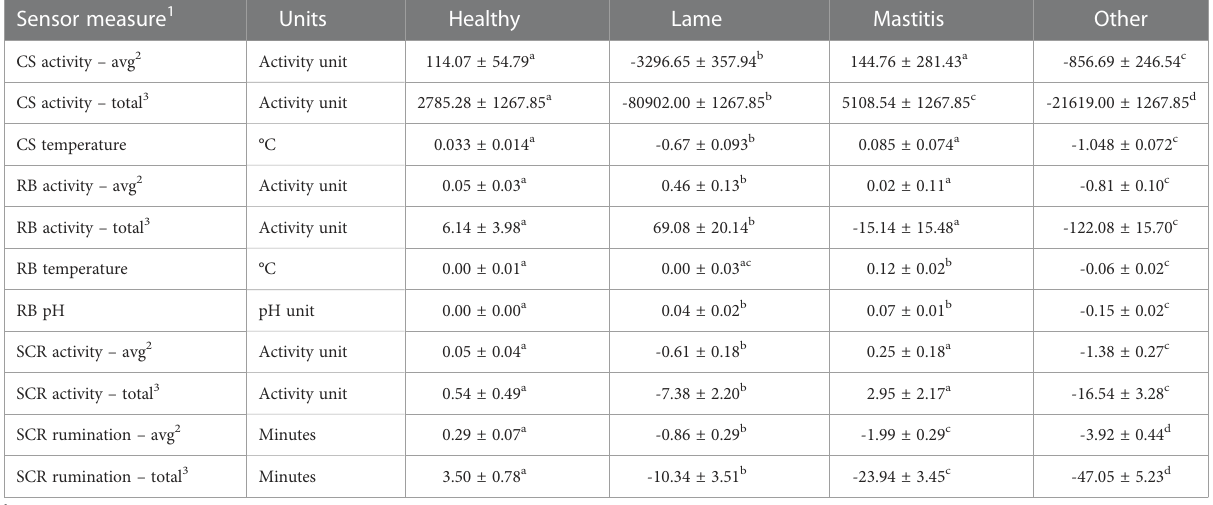
TABLE 3 Least squares means of adjusted sensor measurements 1 within health disorder